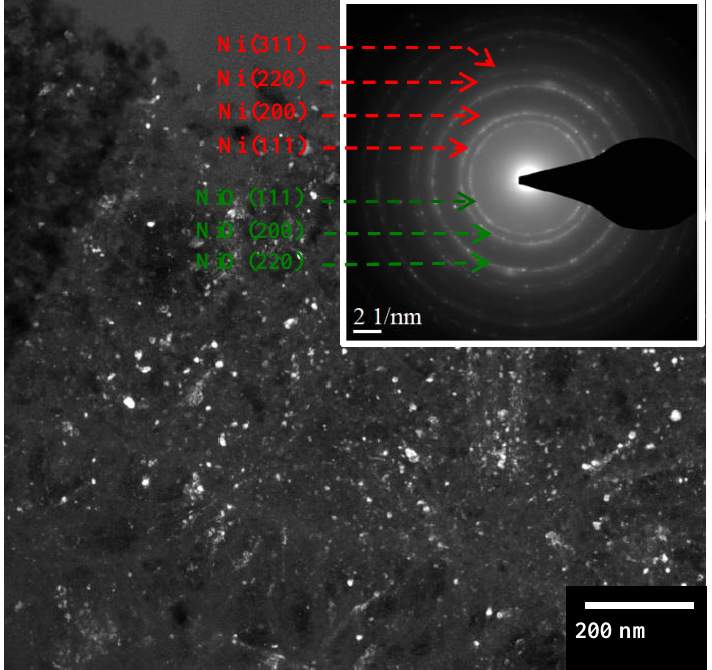
Figure 8. Dark-field image of the TEM cross-sectional microstructure of the NaOH_T + R catalyst. The inset shows the diffraction pattern of the bright particles from the TEM image.